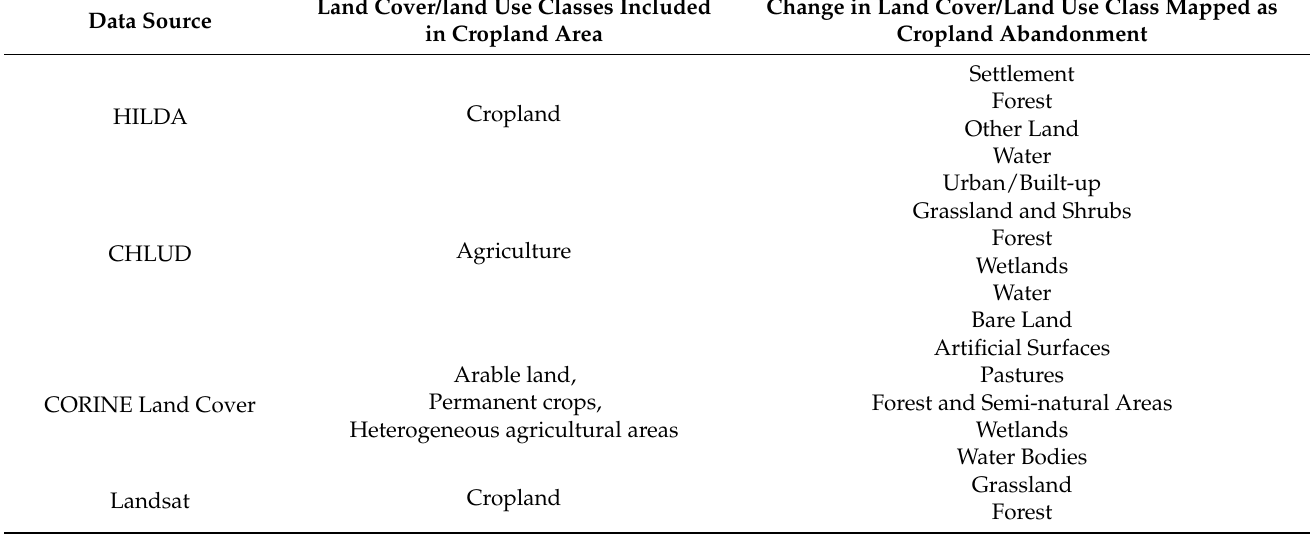
Table 1. Land cover/land use class changes considered as cropland